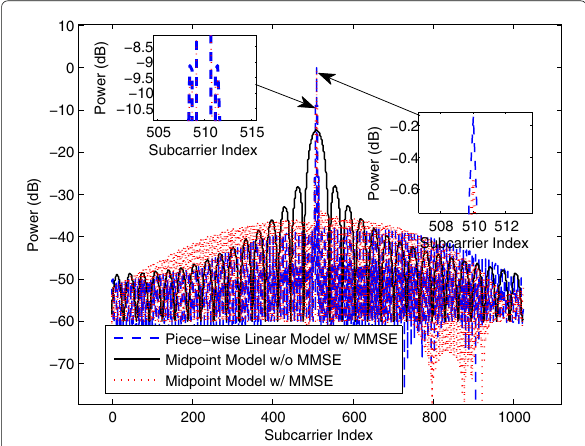
Fig. 4 The power comparison of subcarriers between the midpoint model and piecewise linear model with M = 16, d = 511, N s = 1024, and F d T s =